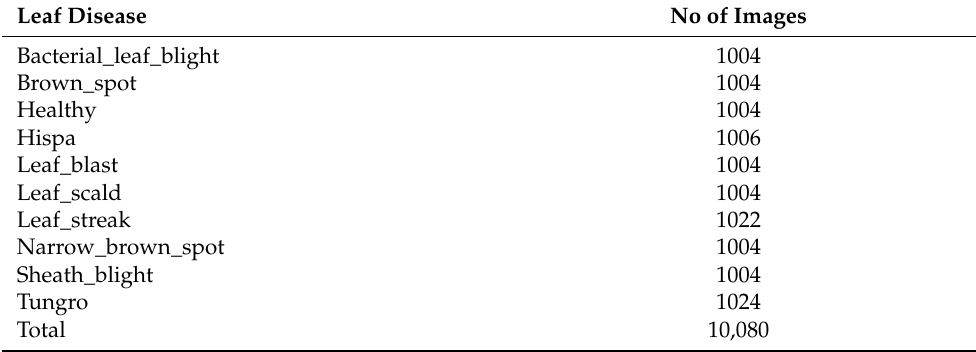
Table 3. Rice leaf disease dataset.